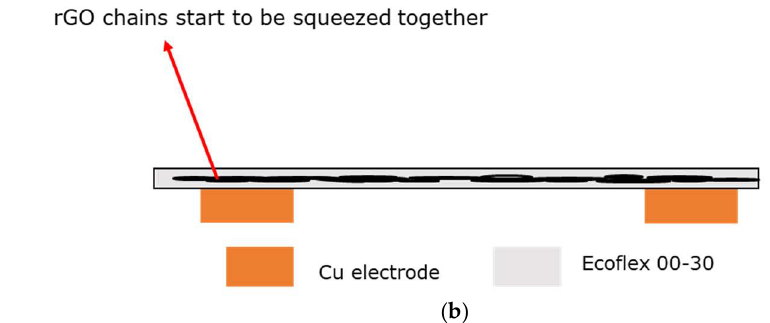
Figure 9. R versus T and I versus V curves of the sensor at 28.5 kPa (Region II) and their fit to ( a , b ) hopping conduction; ( c , d ) Poole–Frankel; ( e , f ) ionic conduction; ( g , h ), Ohmic conduction.